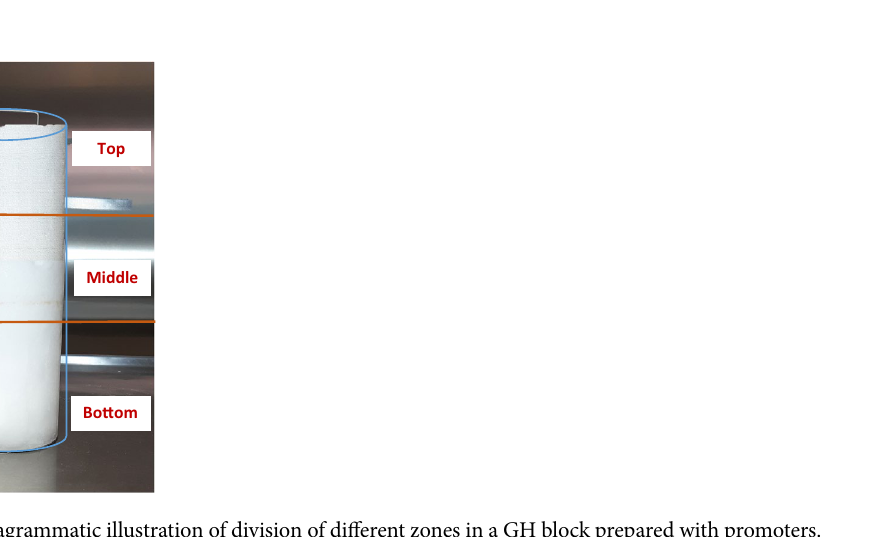
Figure 2. Comparative evaluation of percentage CO 2 gas release ( a ) total, and ( b ) in parts with time from combinational use of amino acids promoters for GH.